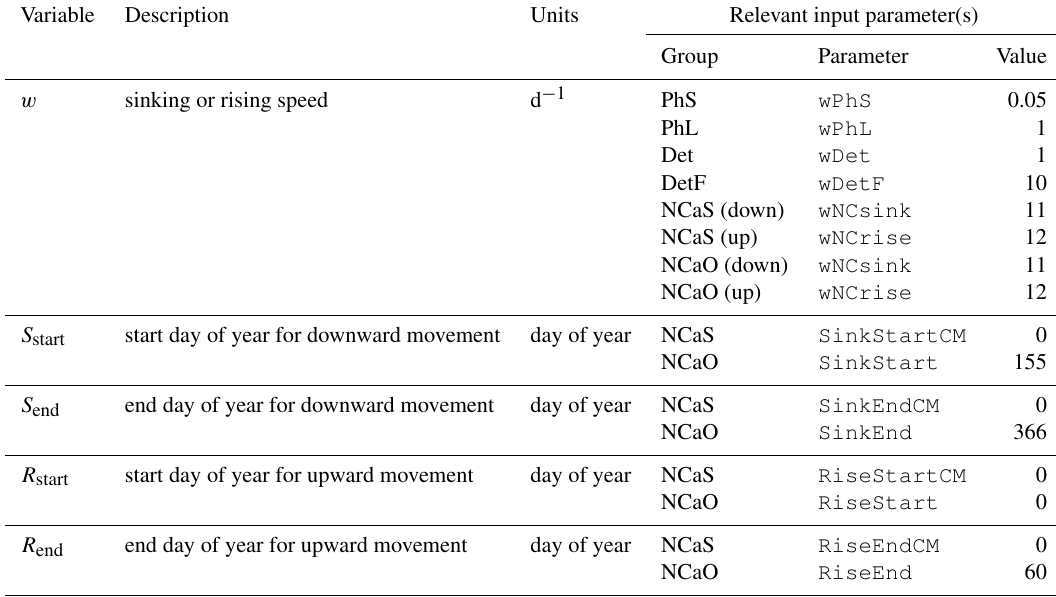
Table A12. Notation and description for input parameters related to vertical movement. Variable